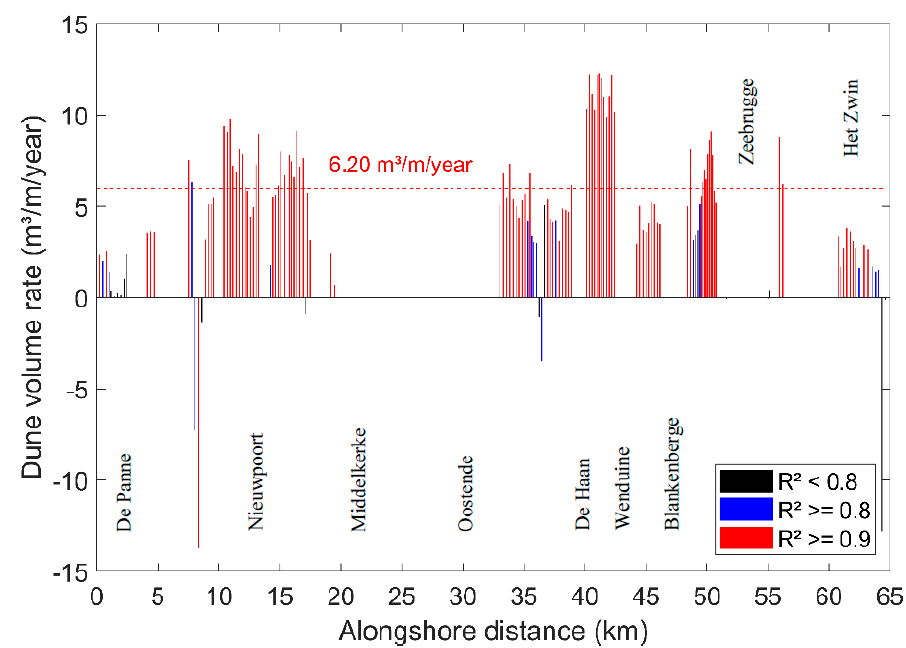
Figure 11. Dune behavior along the Belgian coast for all sections with vegetated dunes (approximately half of the coast). Red bars indicate the places where the correlation coefficient of the linear trend analysis is higher than or equal to 0.9. The red dashed line represents the average annual dune growth for correlations higher than or equal to 0.9.